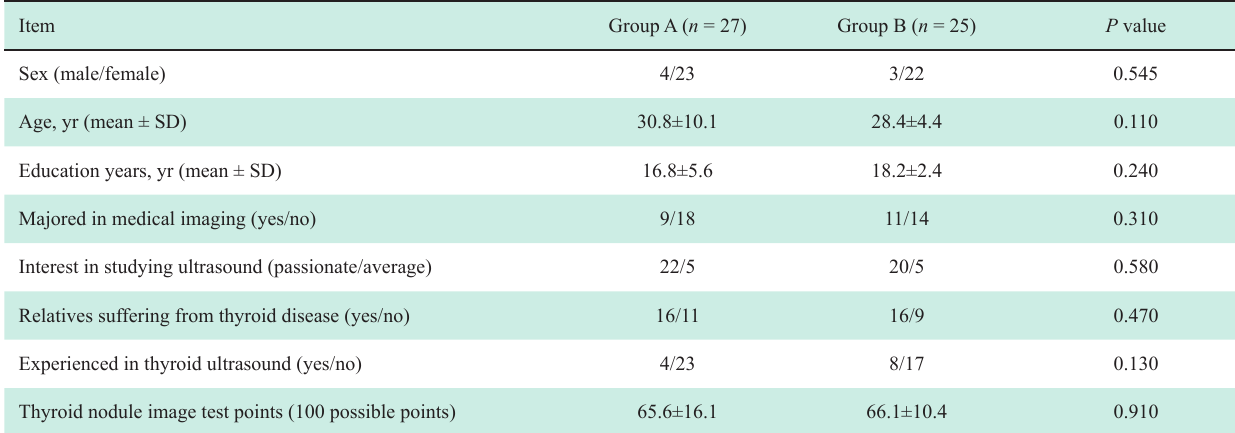
Table 1 The baseline characteristics of Group A and Group B